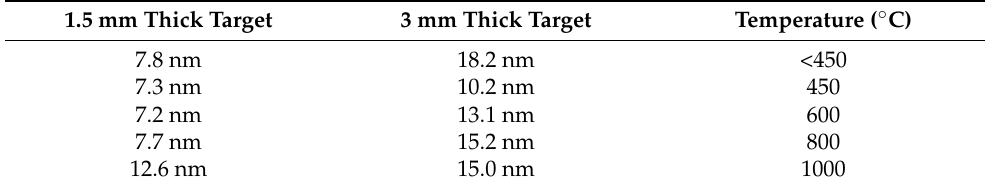
Table 4. Averaged crystallites’ size of nickel coatings deposited in